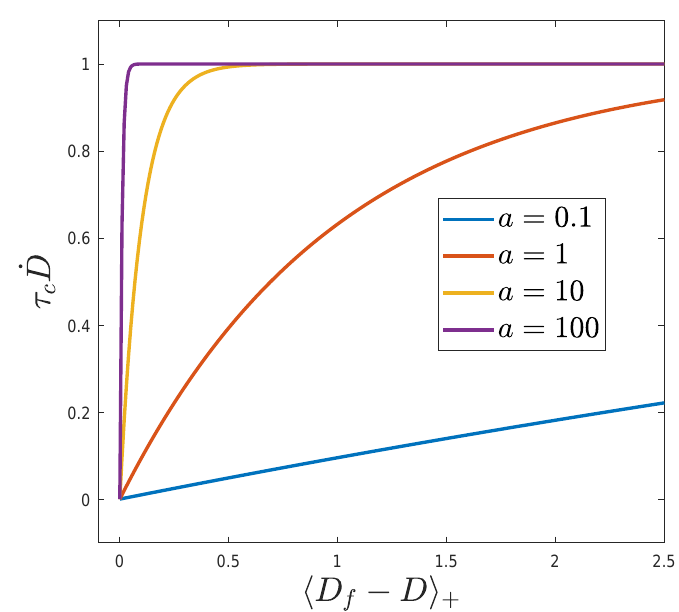
Figure 3. The effect of brittleness exponent a on the rate of damage